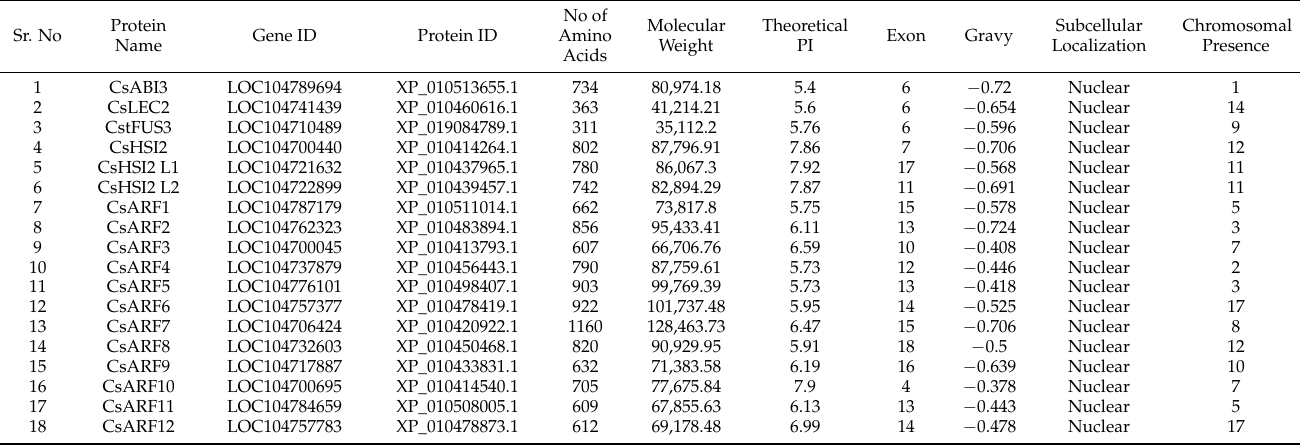
Table 1. Characteristics of B3 domain-containing